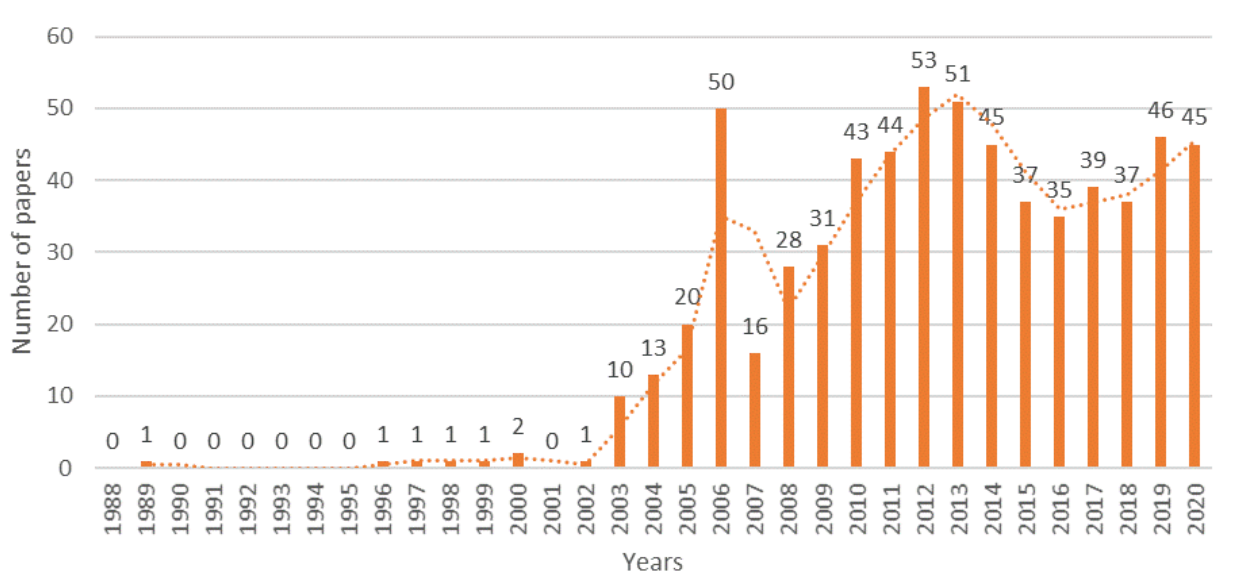
Figure 2. Chronological distribution of ontology- and fuzzy-based IS research.